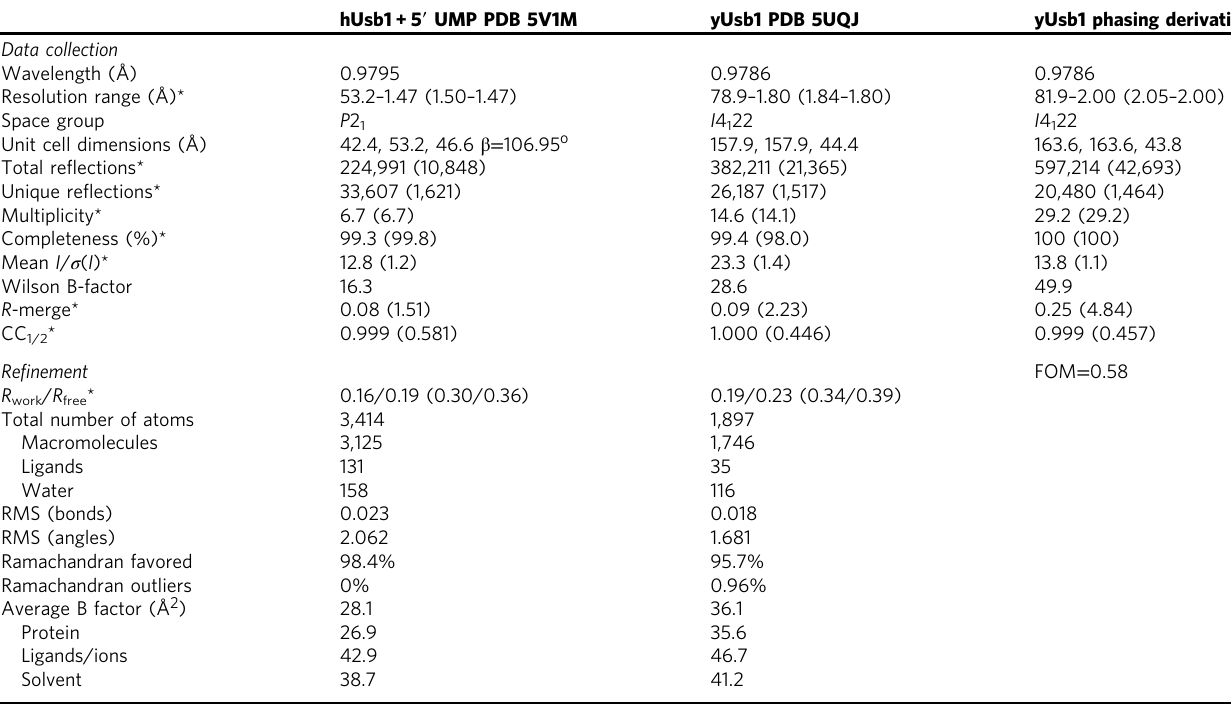
Table 1 Data collection and re fi nement